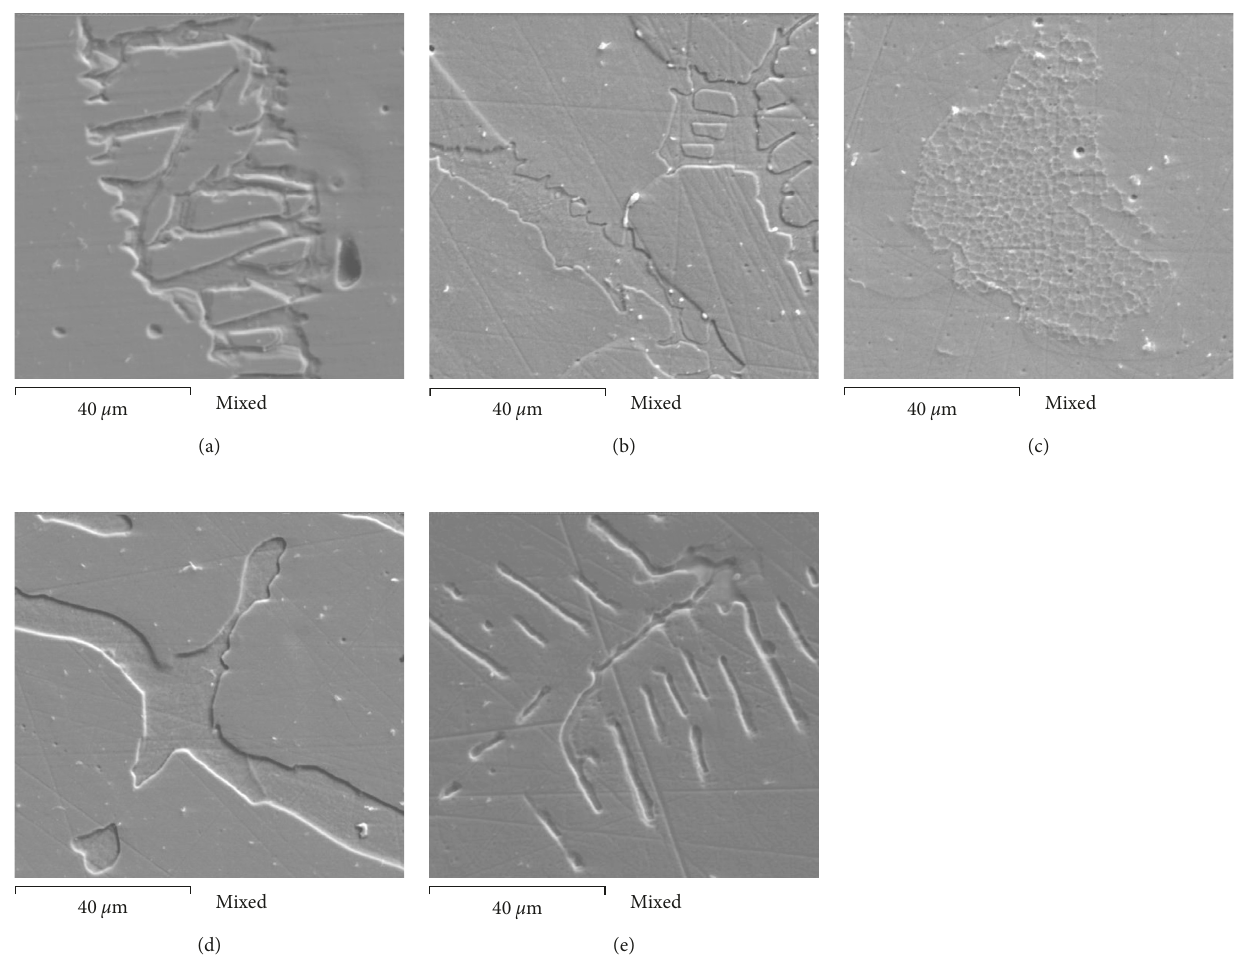
Figure 3: Microstructure of the Ni 3 Al intermetallic alloys: (a) undoped, (b) 1.0% Ag, (c) 1.0% Au, (d) 1.0% Pd, and (e) 1.0% Pt.